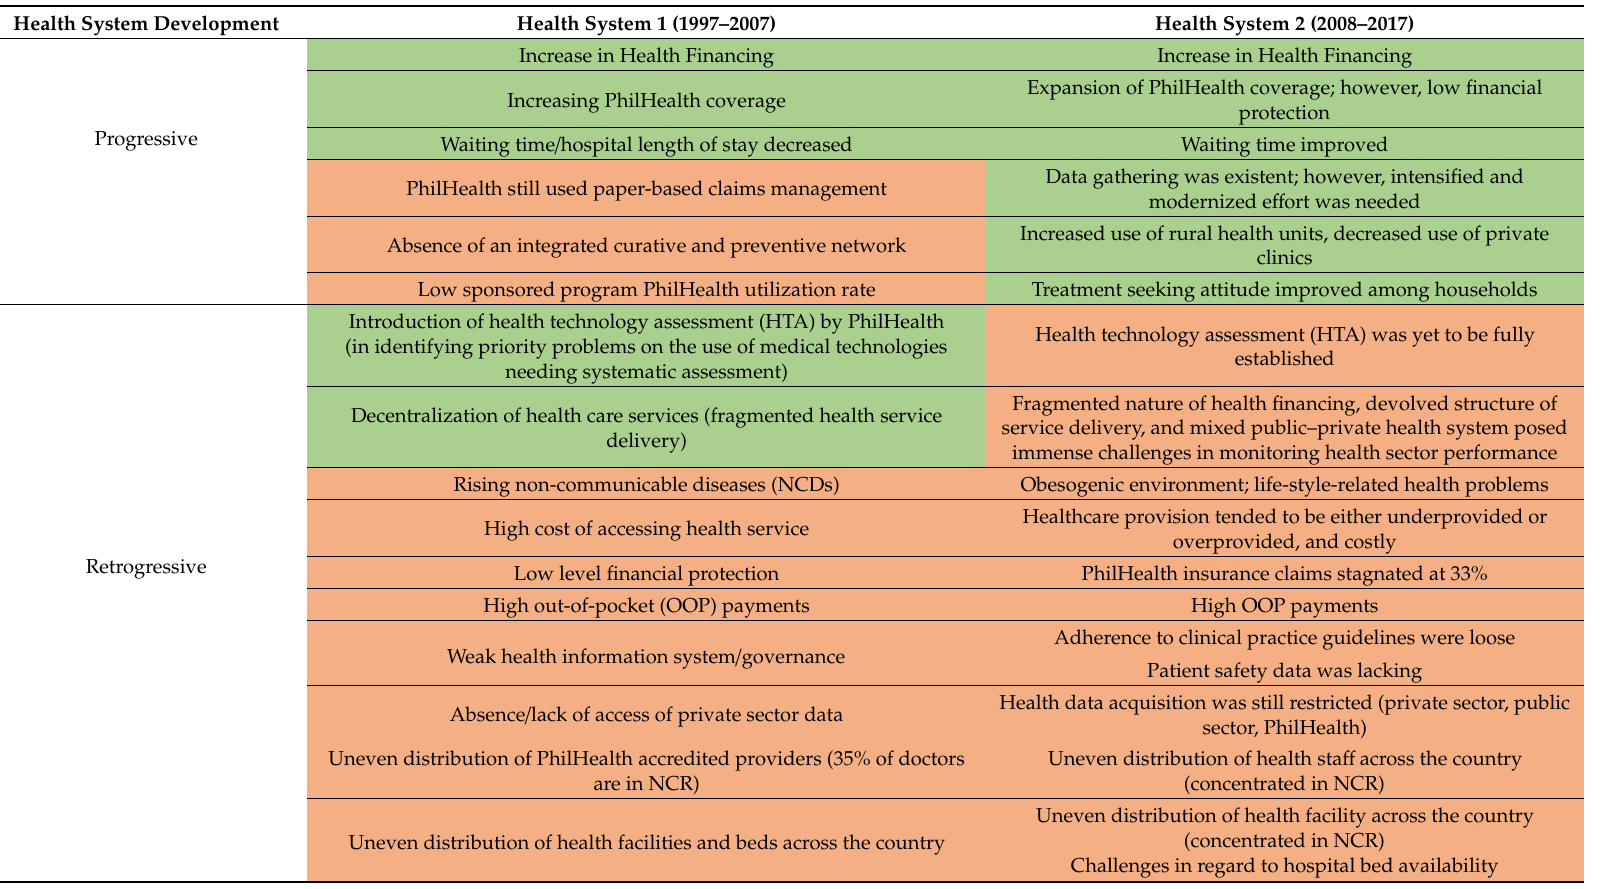
Table 3. Highlighting the health system development from HS 1 to HS 2 using matched